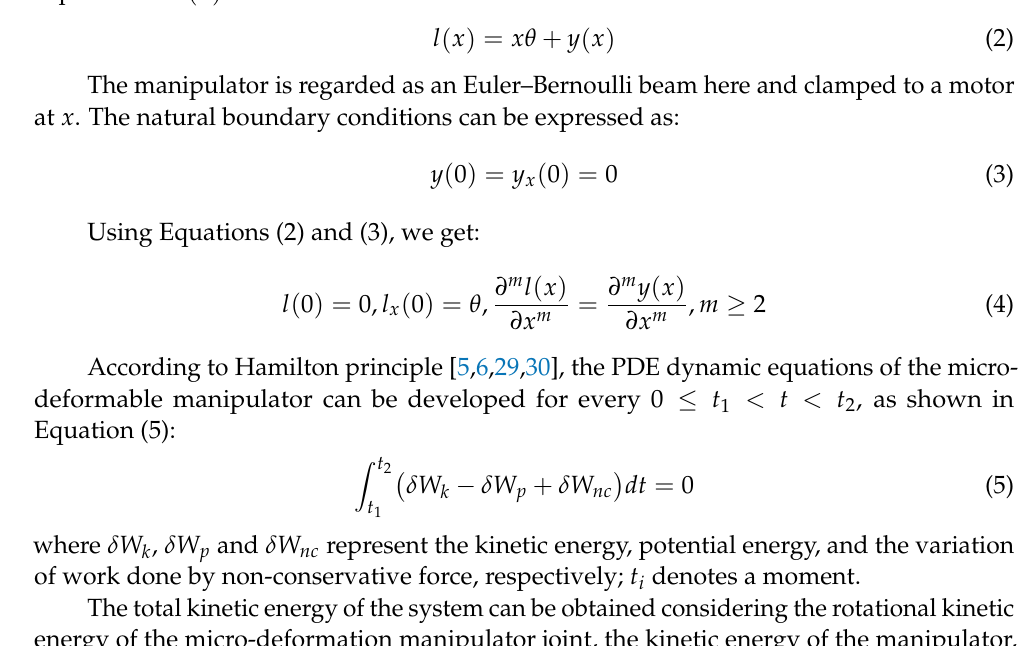
Figure 1. A typical single link micro-deformable manipulator: ( a ) coordinate diagram; ( b ) free-body diagram of the system. The offset of any point, [ x , y ( x )] , in the follow-up coordinate system, xOy , from the micro-deformation manipulator in the inertial coordinate system, XOY , is approximately expressed as l ( x )